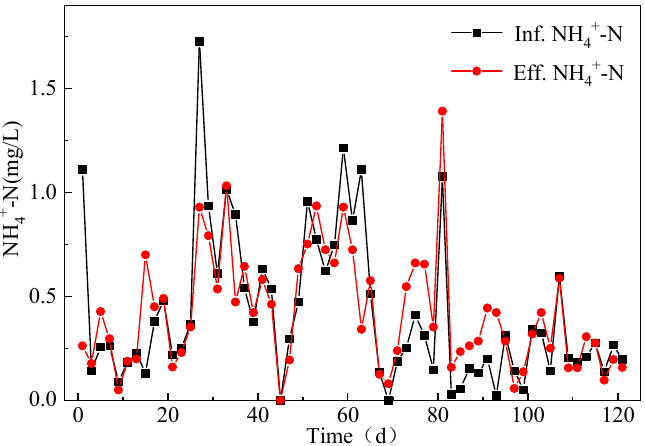
Figure 10. Ammonia nitrogen variation of pilot-scale bioreactor.